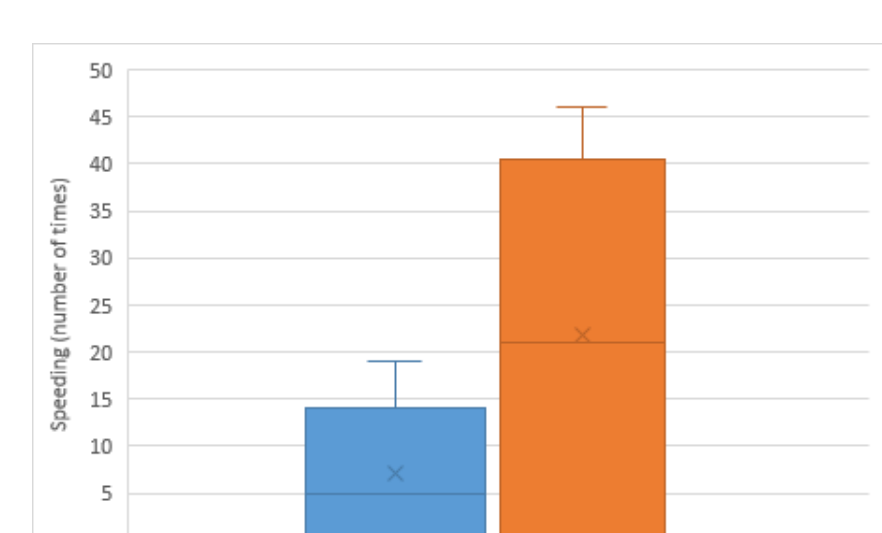
Figure 10. Number of times the driver exceeds the speed limit.